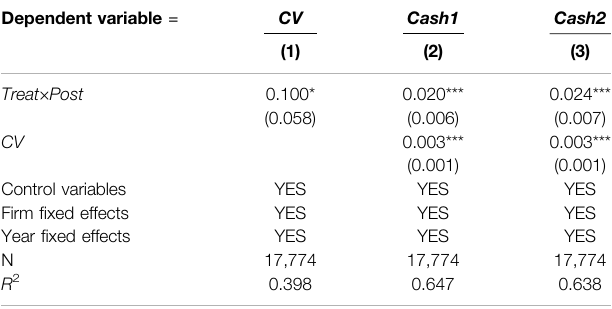
TABLE 7 | Mechanism analysis: Environmental uncertainty. Dependent variable =